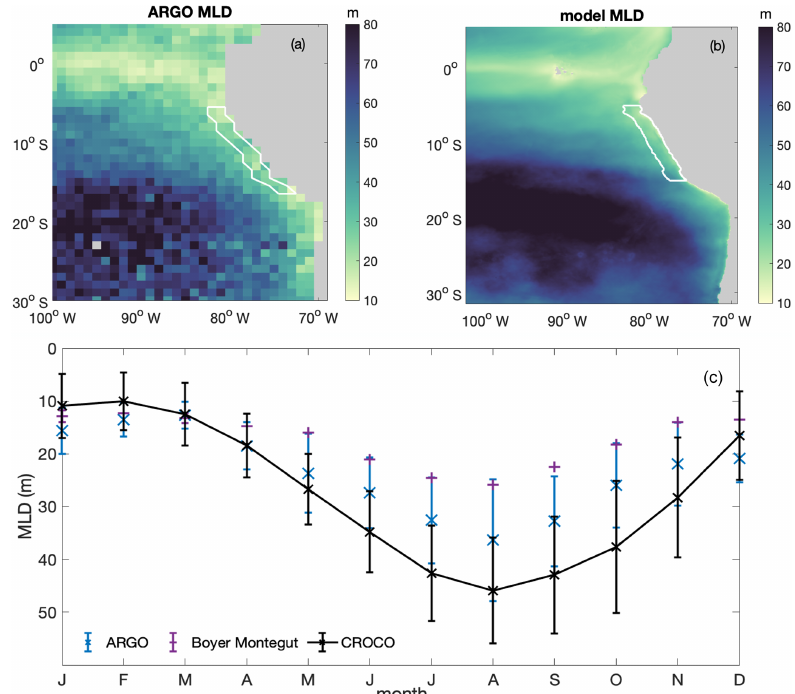
Figure B3. Annual average spatial distribution of mixed layer depth (MLD) from (a) ARGO and (b) CROCO–BioEBUS; (c) seasonal variation in average mixed layer depth from ARGO (blue), the de Boyer Montégut climatology (purple) and model simulation (black), with the error bar indicating the standard deviation within the focus region. White lines highlight the focus region.